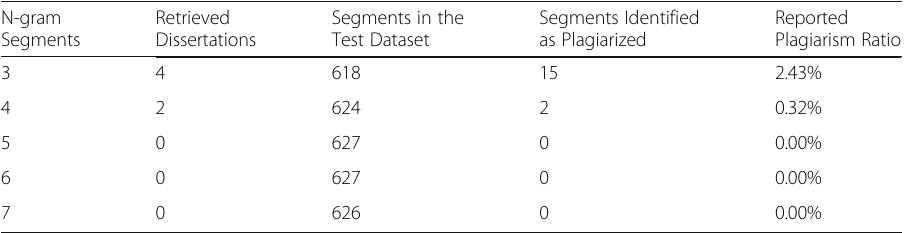
Table 13 Results of experiment I: plagiarism-labeling in the untampered test dataset N-gram